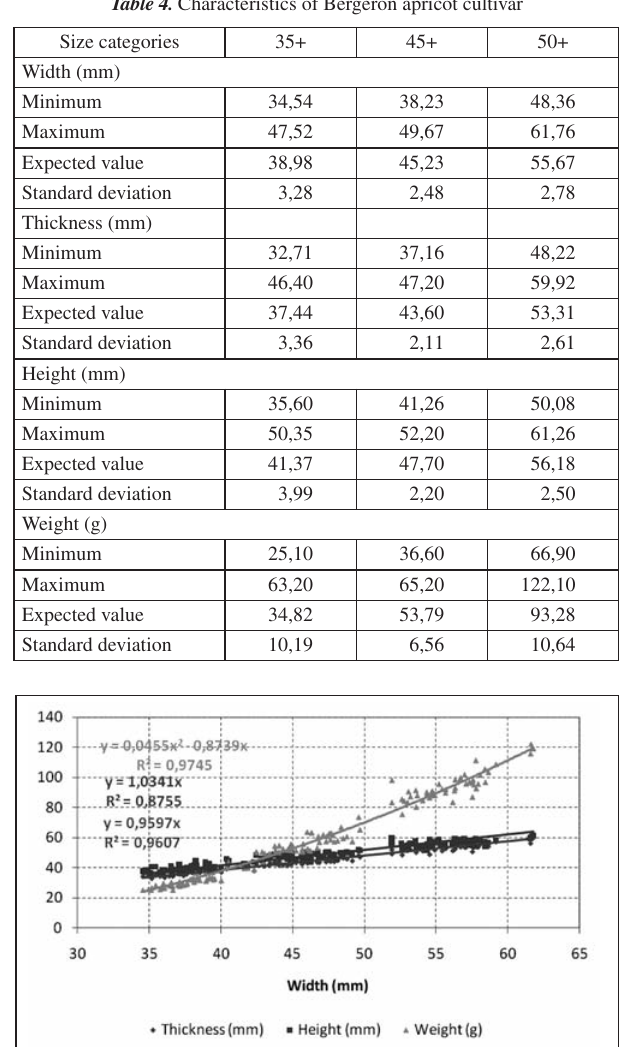
Fig. 29: The connection of the measured data with the width for Bergeron apricot